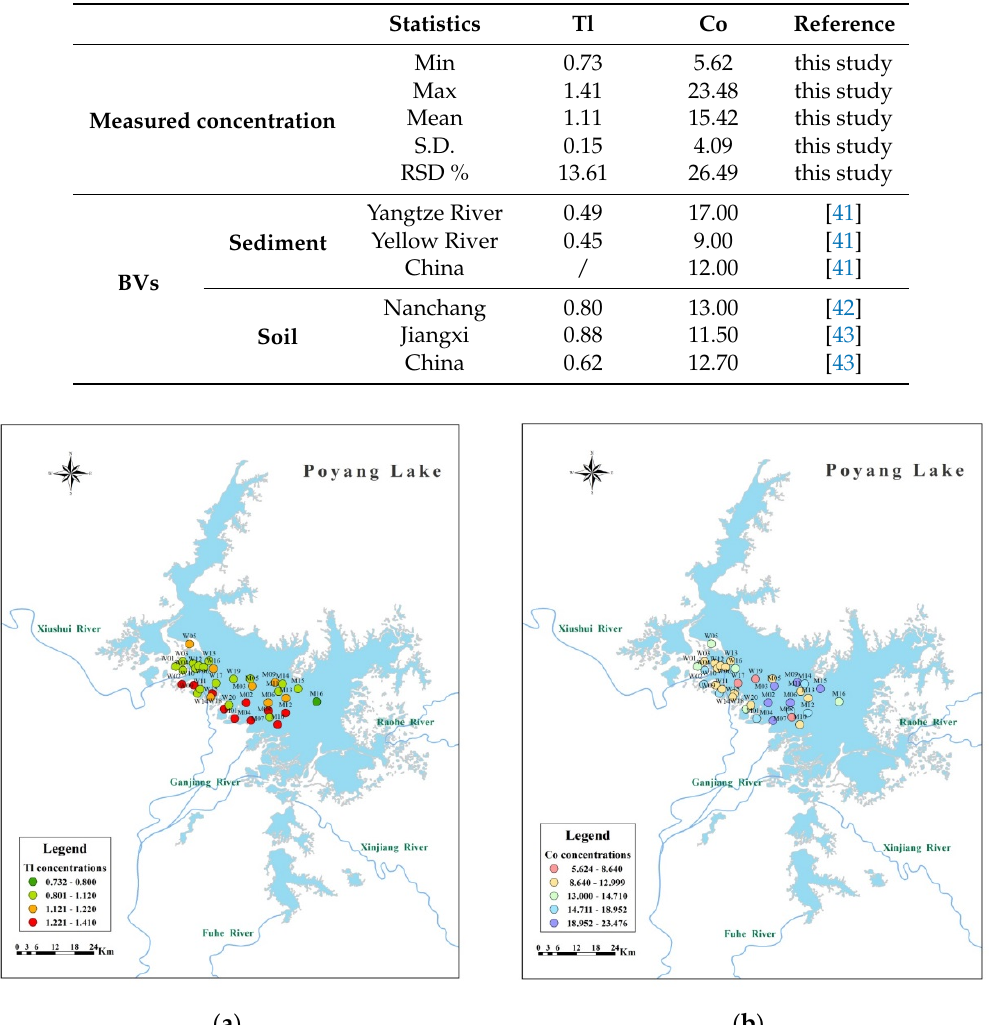
Table 1. Concentrations of Tl and Co in the surface sediments of Poyang Lake (unit: mg/kg).